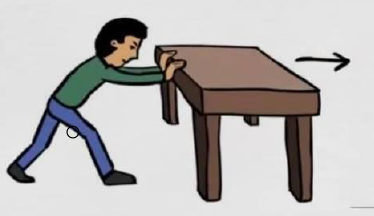
Figure 5: Activities to identify force strength and force